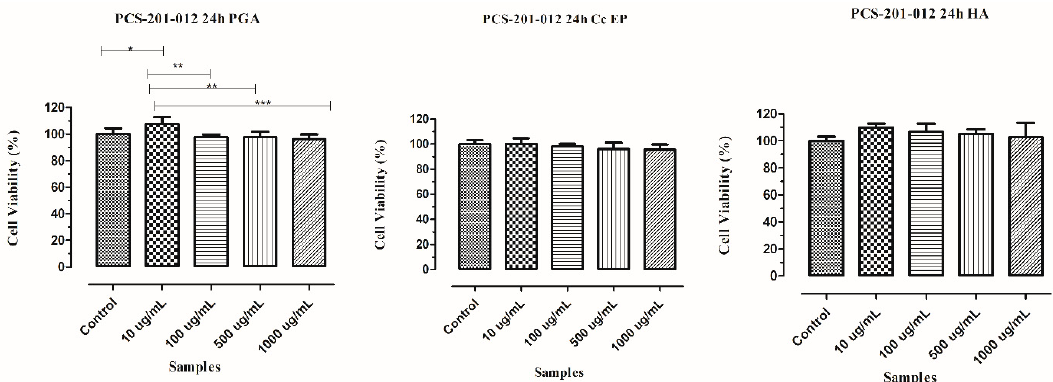
Figure 2. Viability results of pcs-201-012 (Human Dermal Fibroblast Cell line) cells after being cultivated with EP from C. canadensis 28, PGA, and HA (AP value below 0.05 is represented as (*; 0.01 to 0.05, **; 0.001 to 0.01, and ***; <0.001).